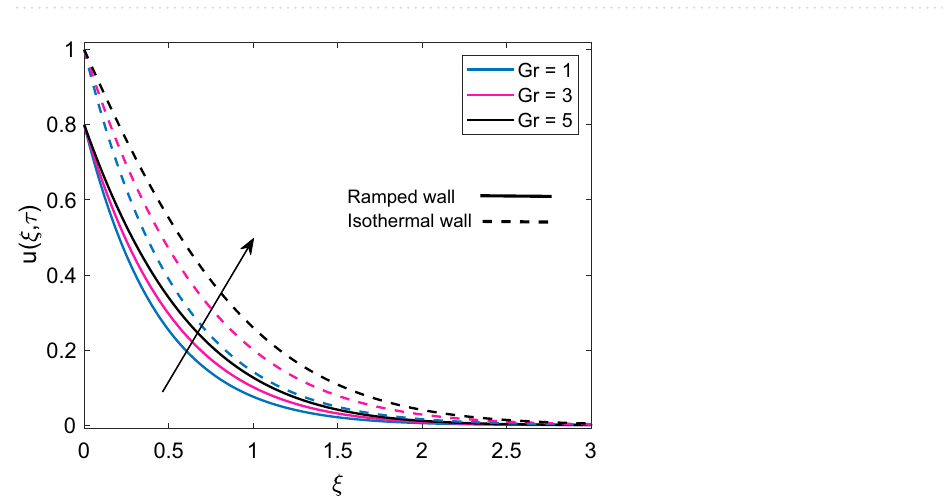
Figure 8. Velocity distribution [Eq. (39)] for various values of M when K = 0.5 , Gr = 5.0 , Nr = 0.5 , φ = 0.1 and Q = 0.5 .